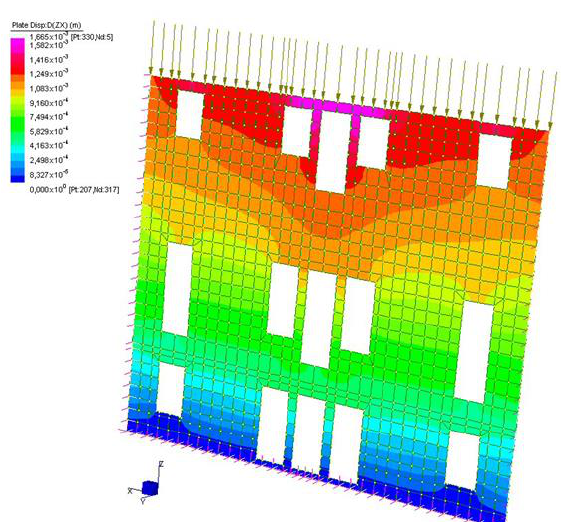
Figure 20: Analysis of deformations due to the roof